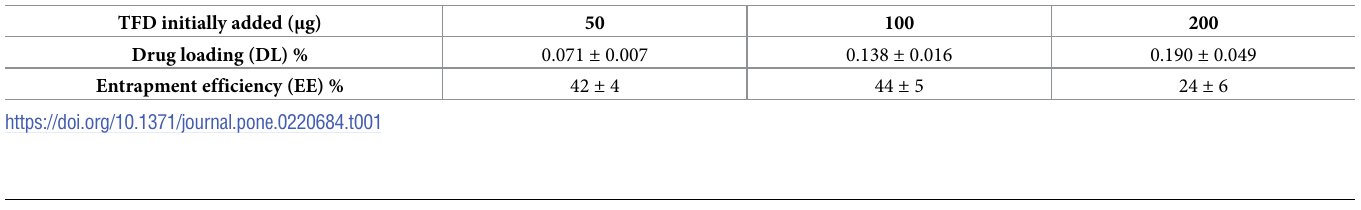
Table 1. Drug loading and entrapment efficiency of